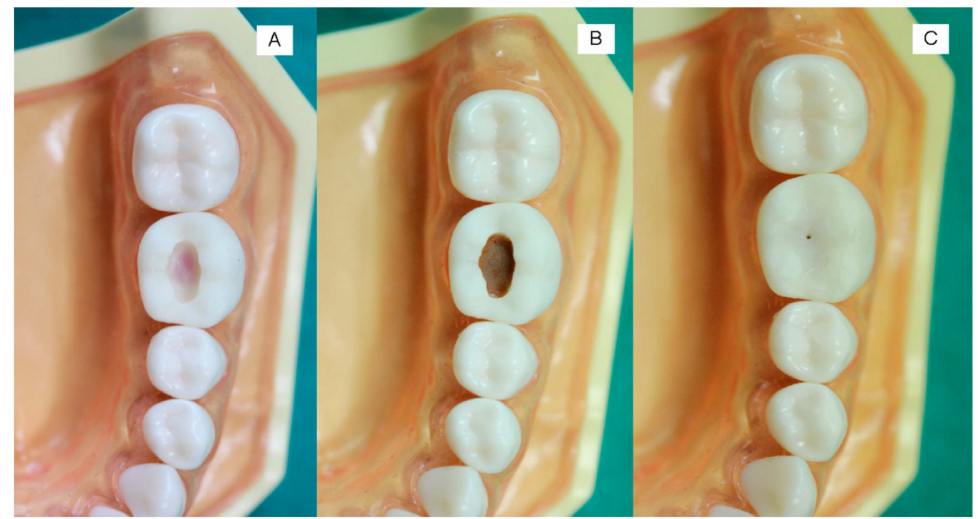
Figure 3. The steps to create a Class I cavity. ( A ) We filled the tooth with red-colored dental wax from the bottom side to mimic the dental pulp. ( B ) We filled the tooth with RMGIC mixed with a color modifier for ~3 mm to mimic a caries lesion. The light-curing time was 5 s. ( C ) We filled the final layer with a nanofilled resin composite. We created the small opening to guide the students to the location of cavitated caries.